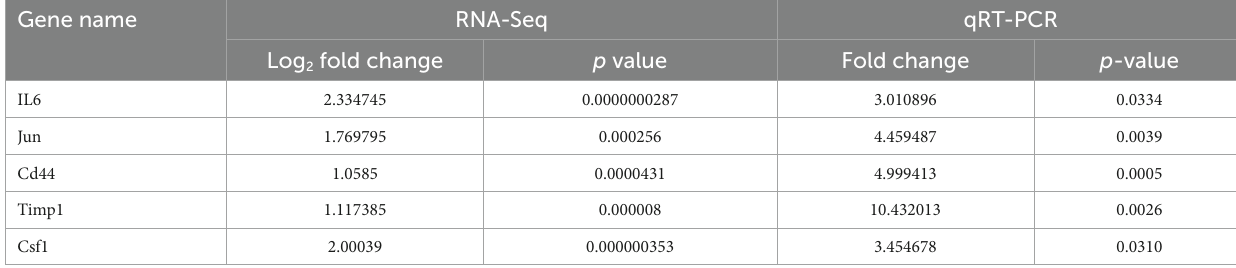
TABLE 4 The comparison information of the RNA-Seq and qRT-PCR data of the SNT mice vs. the